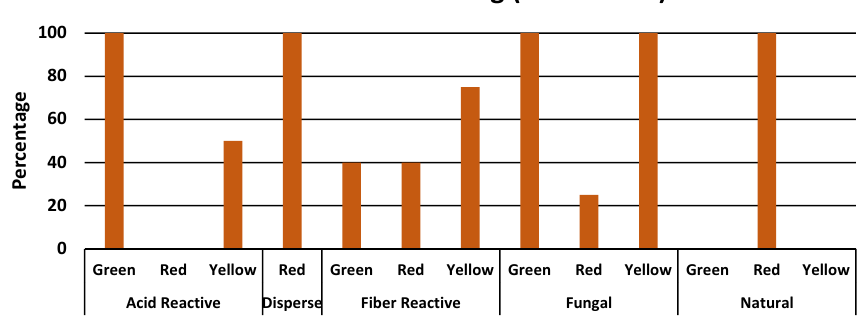
Figure 6. Results for colorfastness to wet crocking, mordanted.